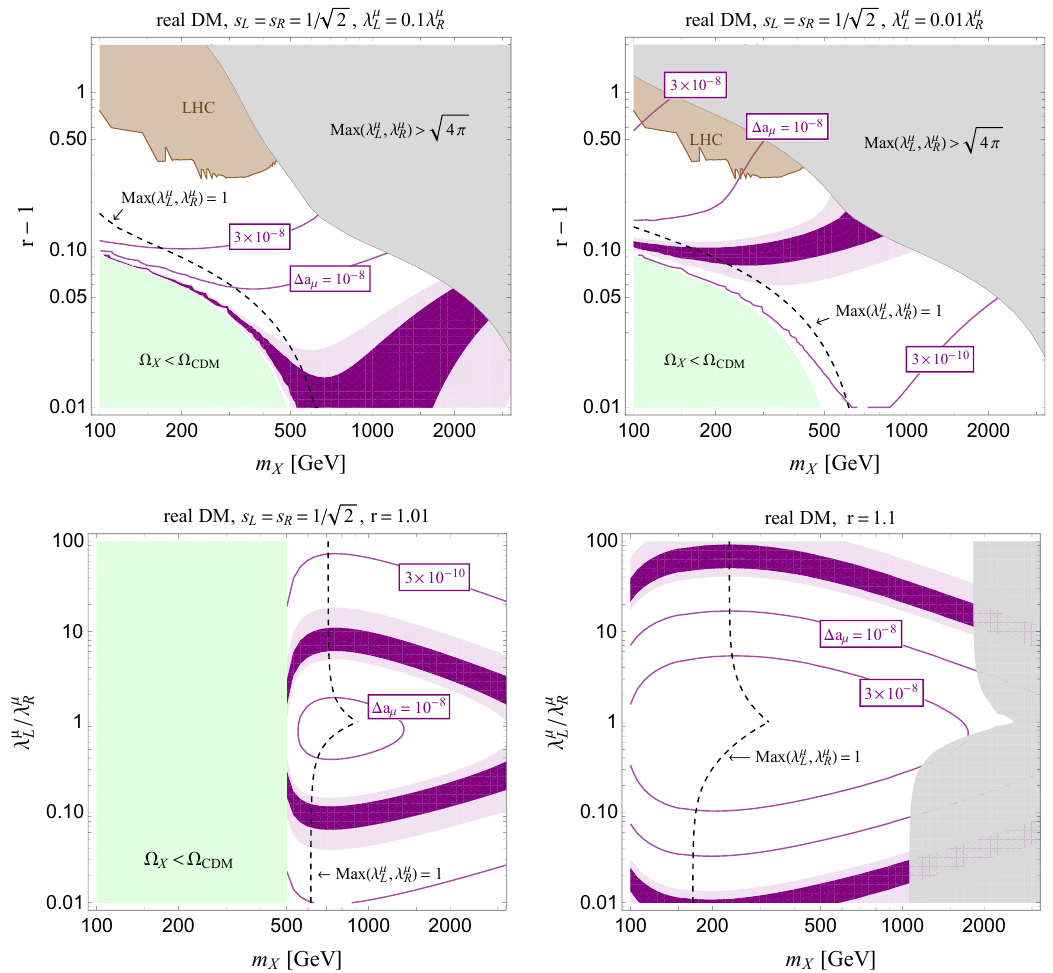
Figure 10 . Parameter space consistent with the DM observations in the real DM model with the maximally mixed vectorlike leptons s L = s R = 1 = p 2. We show the induced values of (cid:1) a (cid:22) with the purple lines. (cid:1) a (cid:22) is explained in the (light) purple region within 1 (cid:27) (2 (cid:27)